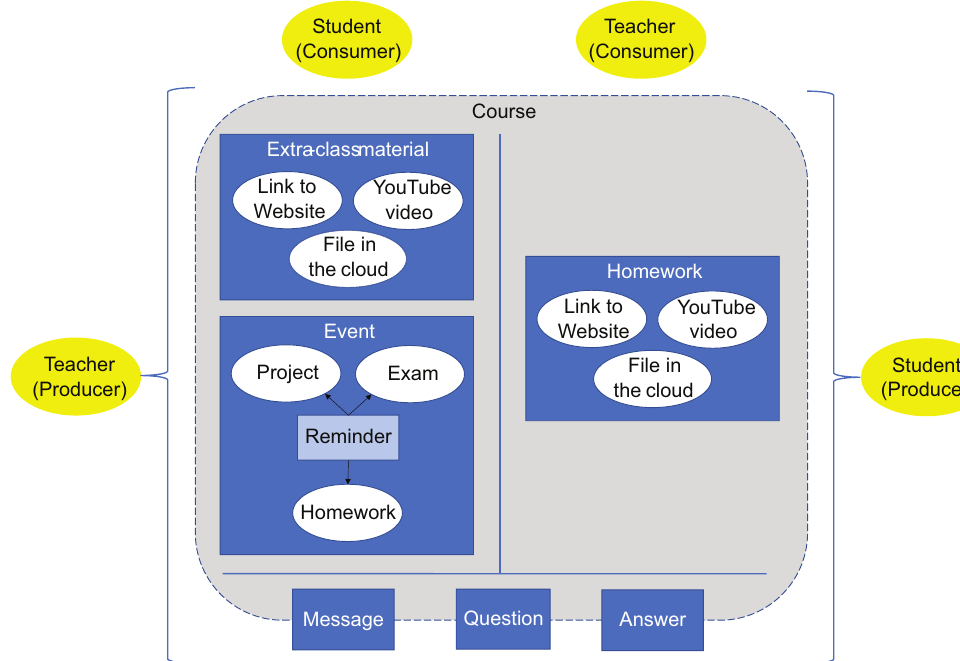
Figure 2. Teacher and student role models using the producer/consumer